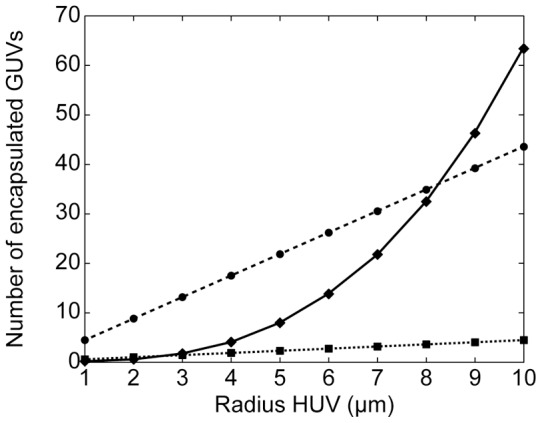
Predictions of the minimal and maximal number of encapsulated giant unilamellar vesicles (GUVs).The minimal number (dashed lines) of encapsulated GUVs needed to induce sedimentation of an intact hierarchical unilamellar vesicle (HUV) of a given size is different for the sedimentation induced by centrifugation (squares) and induced by spontaneous sedimentation (circles). The maximal number (solid line) of encapsulated GUVs that can be packed into an intact HUV of a given size (diamonds) solely depends on the volume available.